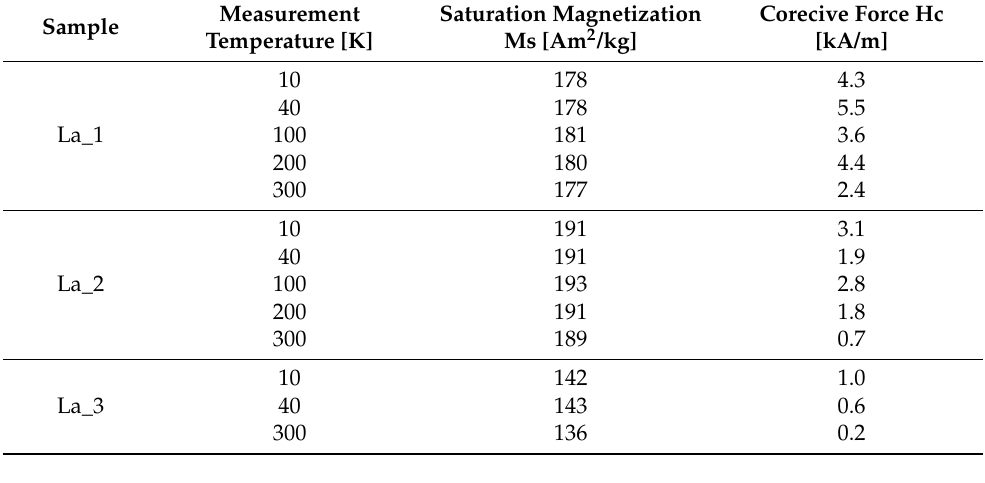
Table 7. Magnetic properties (saturation magnetization-Ms and coercive force-Hc) of the La_1, La_2, and La_3 alloy tapes. Measurement Saturation Magnetization Sample Temperature [K]